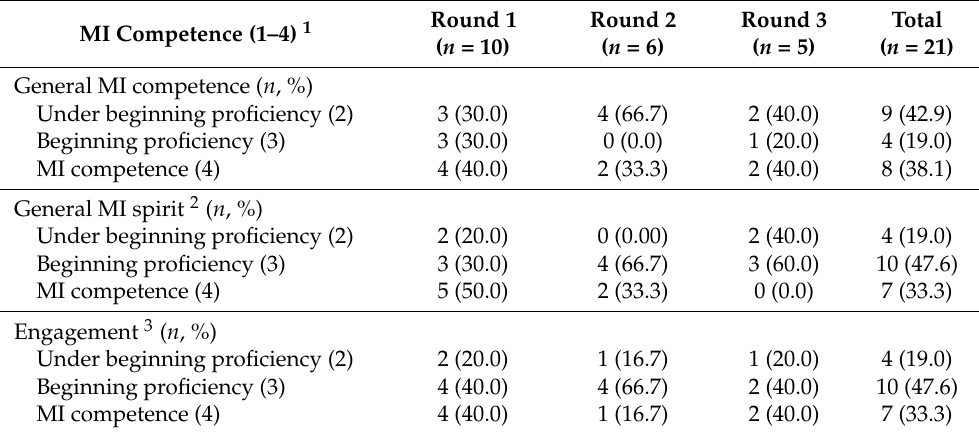
Table 3. Frequency and percent of the motivational interviewing (MI) competence scores by MI trainers for 21 recordings across three consecutive